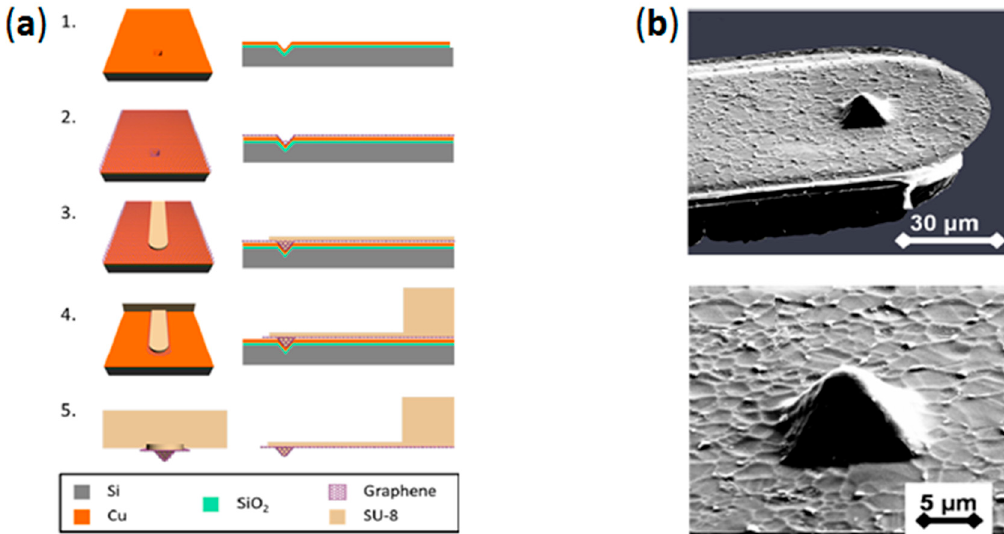
Figure 3. Schematic of graphene coated SU-8 AFM probes obtained by CVD graphene transfer using a mold. ( a ) Fabrication procedure of graphene coated SU-8 AFM probes; ( b ) SEM images of released graphene coated SU-8 AFM probes (top) and zoom in probe apex (bottom). Reproduced with permission from [26], copyright ACS Nano